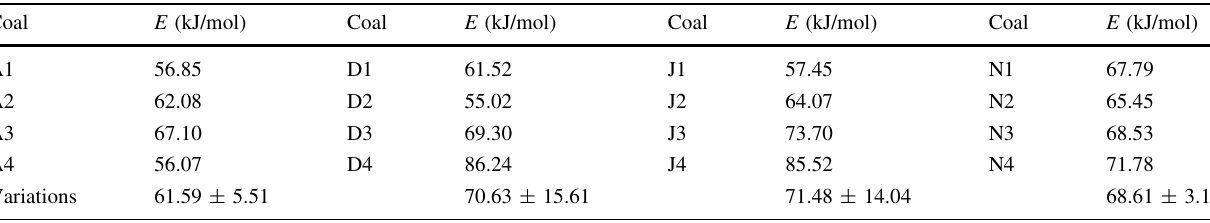
Table 5 Activation energy of different coal (A, D, J and N)